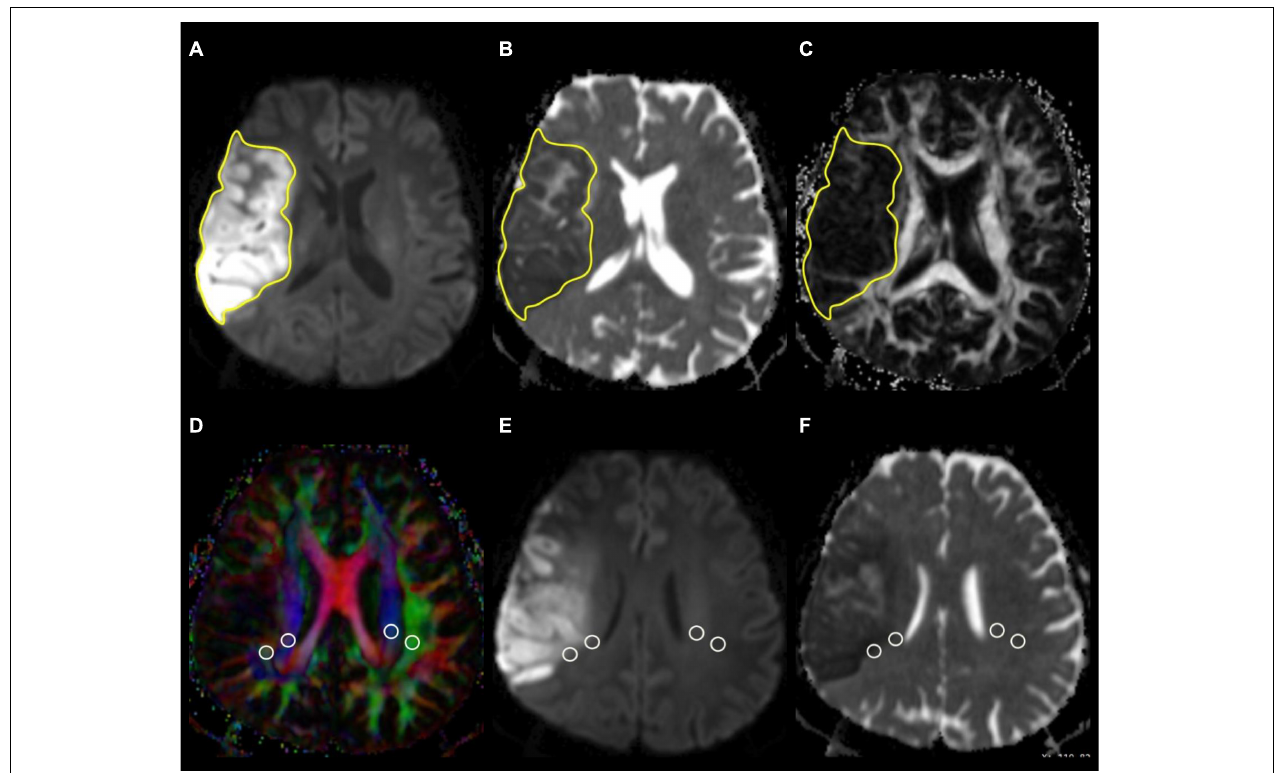
FIGURE 1 | Example of how regions of interest (ROIs) were segmented. Transverse isotropic diffusion-weighted (A) , apparent diffusion coefficient (B) , and fractional anisotropy images show manually drawn ROIs for measurement of infarct volume, ADC, and FA values. Directionally encoded color map (D) illustrates ROIs of projection (blue area) and association (green area) fibers in bilateral periventricular regions. On the co-registered isotropic diffusion-weighted (E) and apparent diffusion coefficient (F) images, these ROIs do not include infarcted